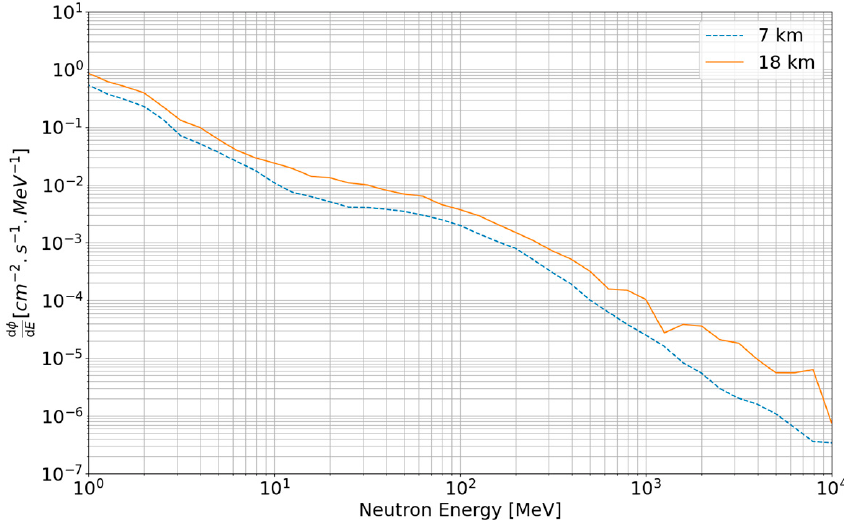
Figure 12. Spectrum of secondary neutrons at 7 and 18 km given by RAMSEES (Radiation Atmos- pheric Model for Single Event Effect Simulation).